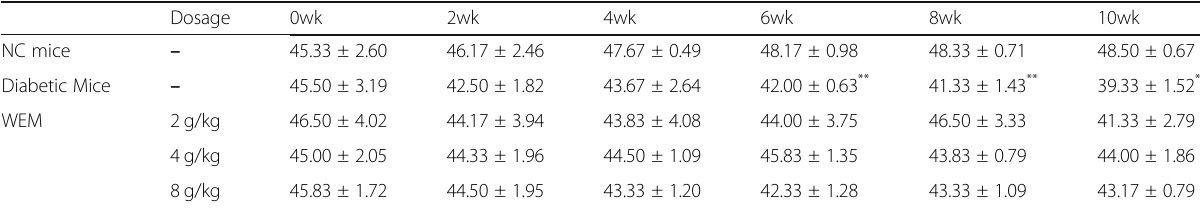
Table 2 Fasting Weight (g) Concentrations Following Treatment Dosage Diabetic